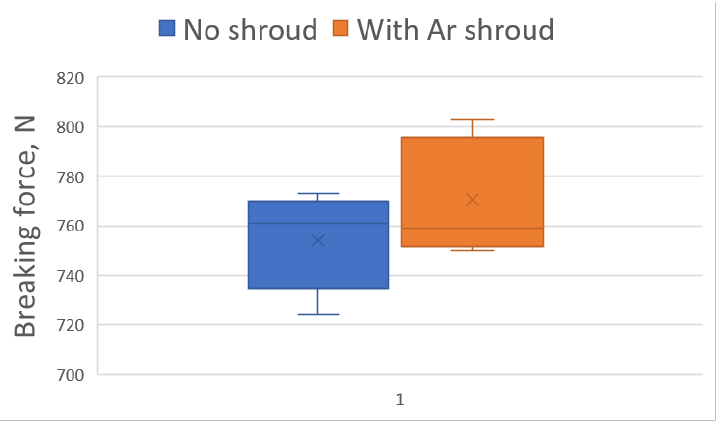
Figure 11. Results of tensile shear test.